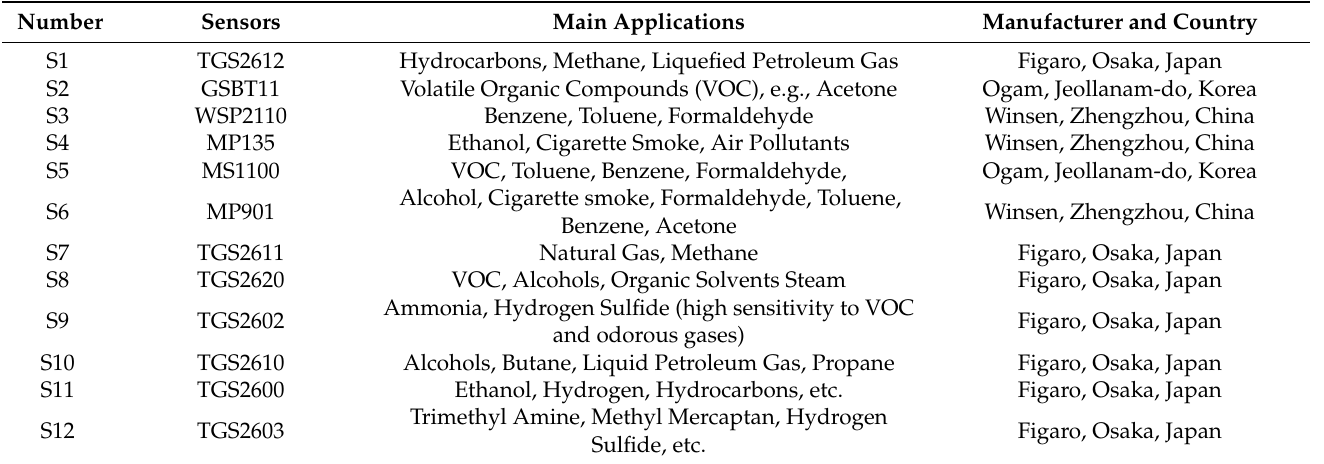
Table 1. Application of sensors used in the sensor